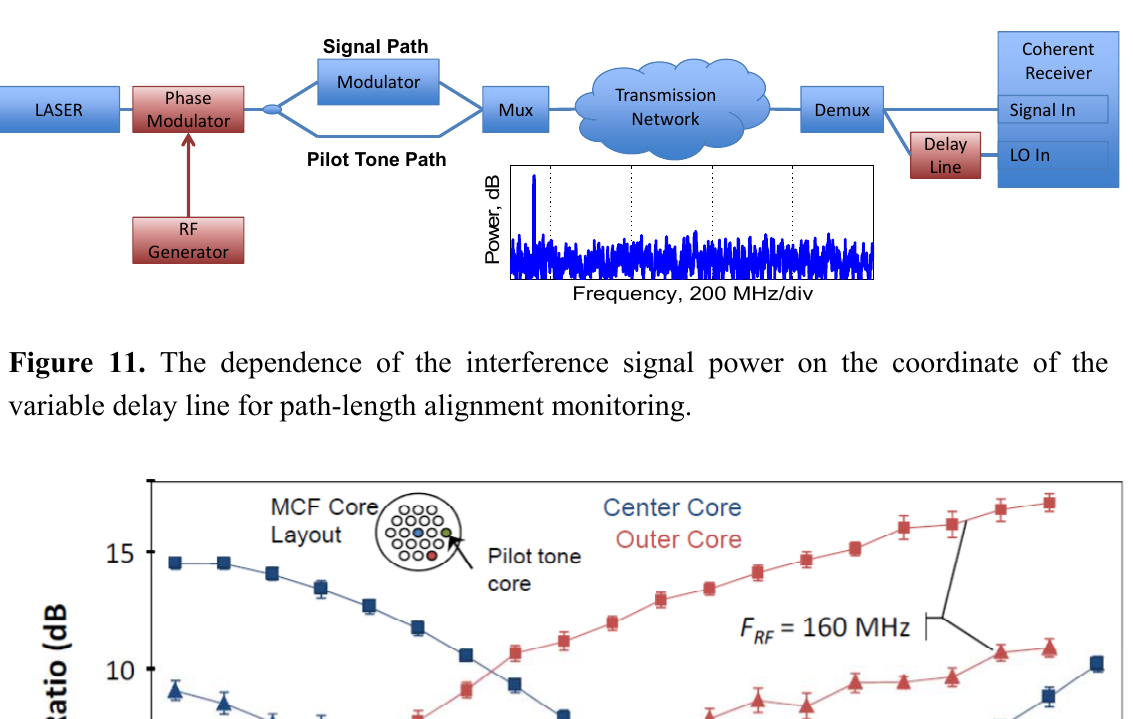
Figure 10. Path-length alignment monitoring subsystem. LO, local oscillator.